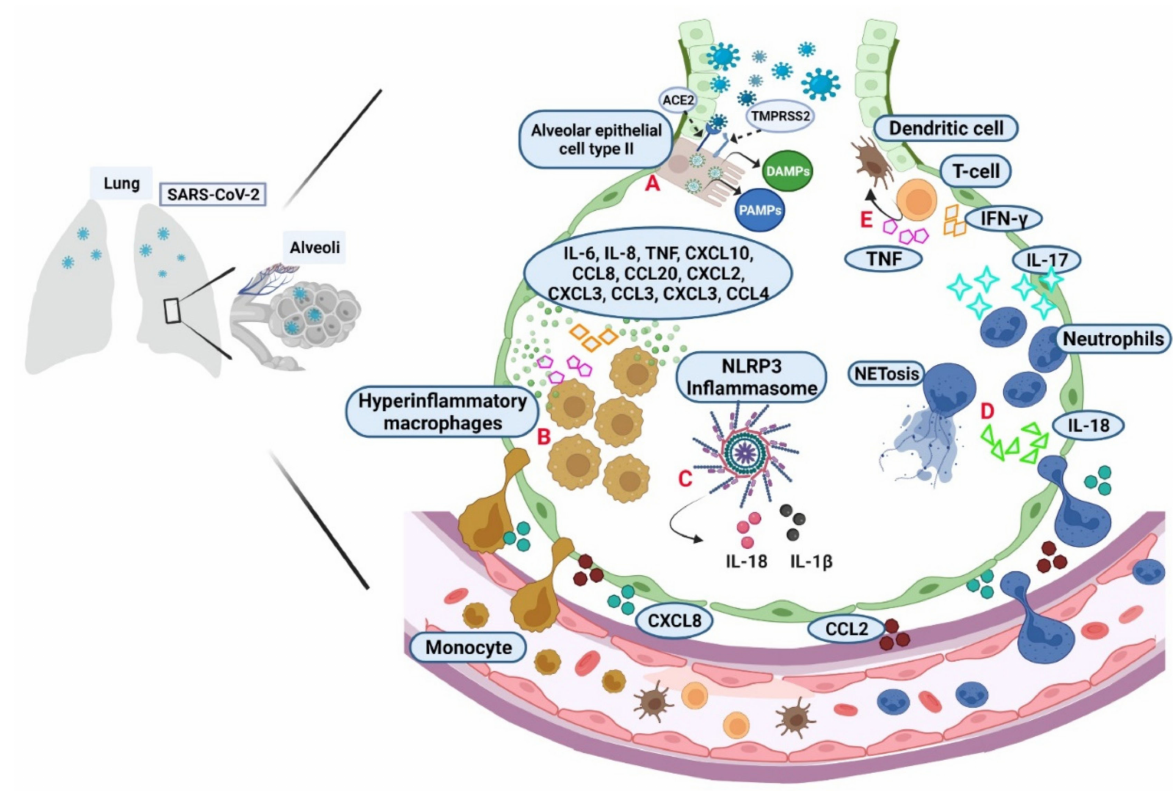
Figure 1. Activation of the immune response during the SARS-CoV-2 infection